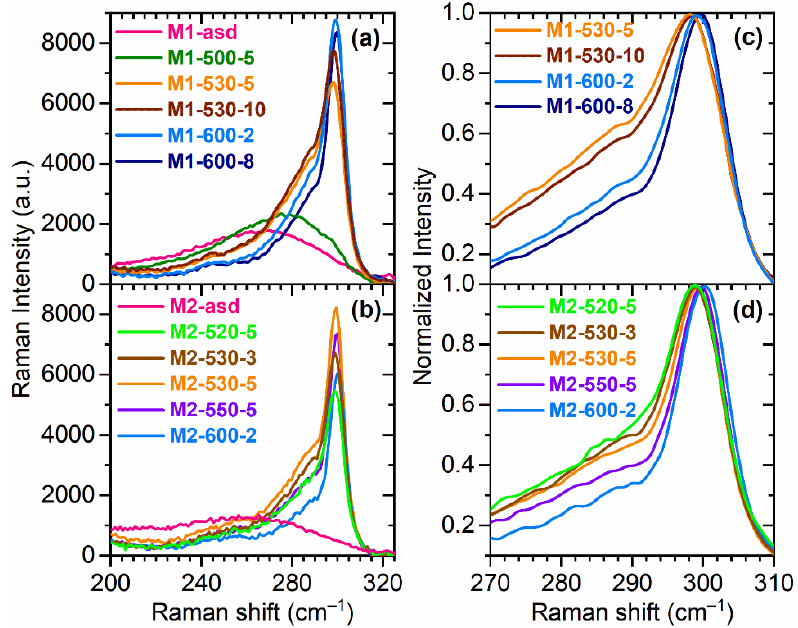
Figure 3. Raman spectra: ( a , b ) as-deposited and RTA samples M1 and M2, respectively; ( c , d ) normalized spectra of annealed structures M1 and M2, respectively plotted in the 270–310 cm − 1 region corresponding to Ge-Ge mode in SiGeSn